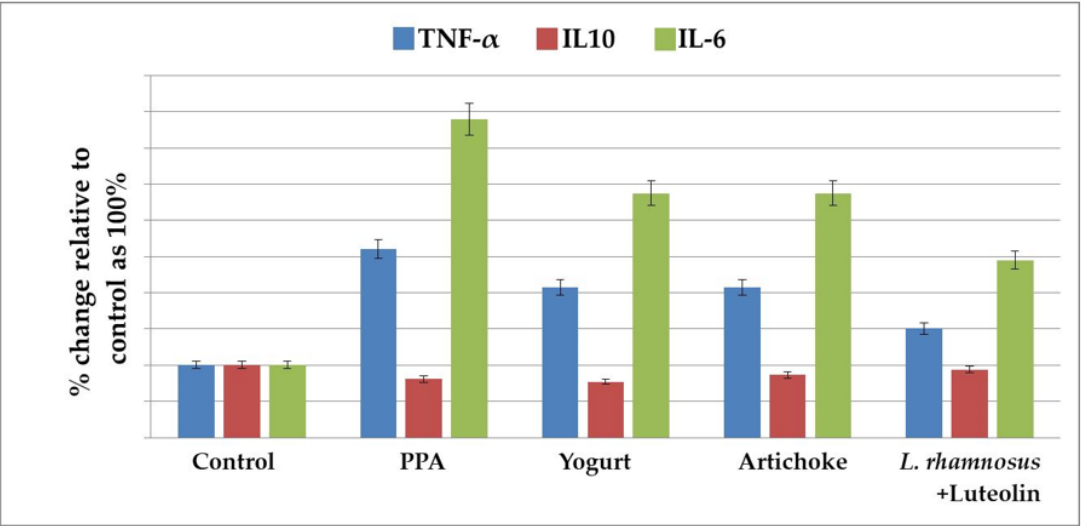
Figure 2. The percentage change in TNF- α , IL10, and IL-6 levels in the brain homogenates of an untreated PPA-induced autism model and nutritionally treated groups of yogurt, artichokes, and combined L. rhamnosus GG + luteolin relative to the control, presented as 100%.